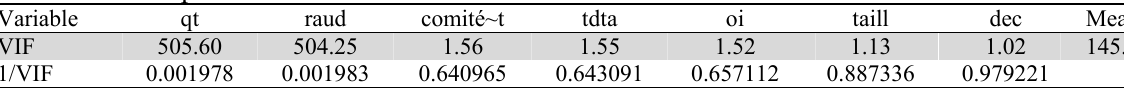
VIFs of the independent variables